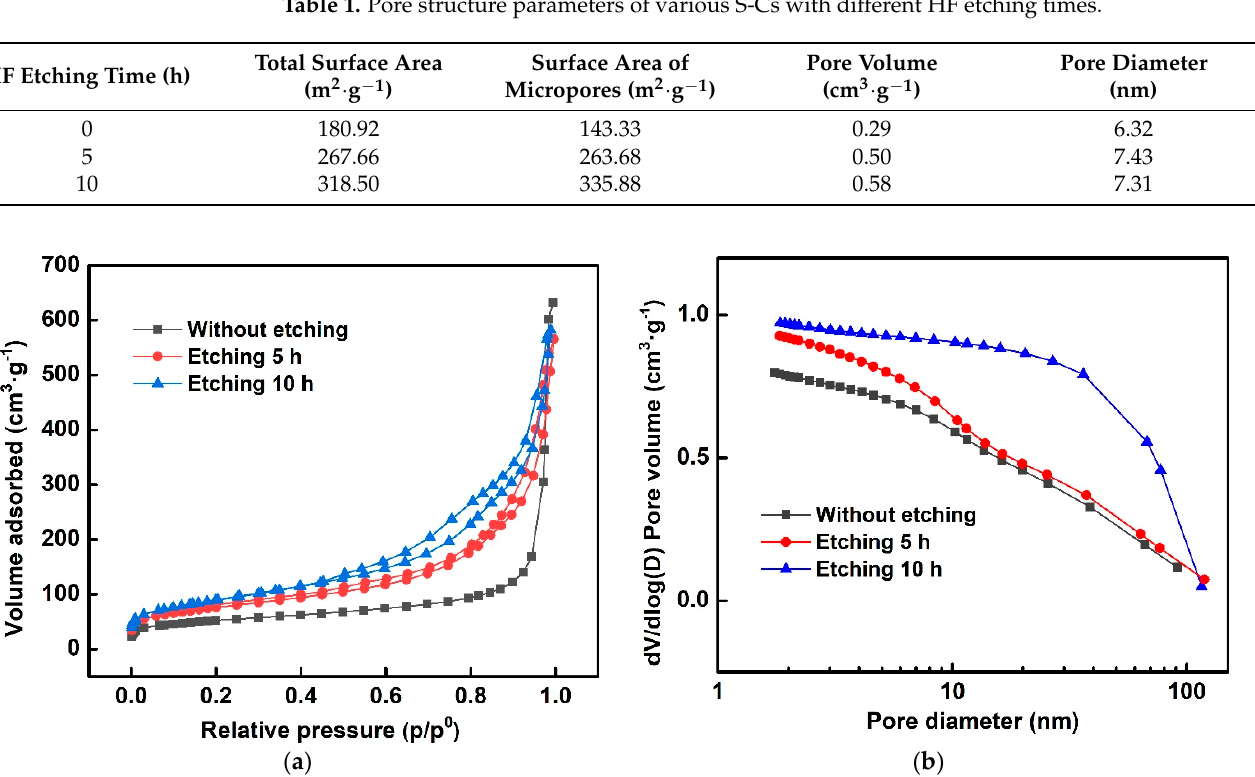
Table 1. Pore structure parameters of various S-Cs with different HF etching times.